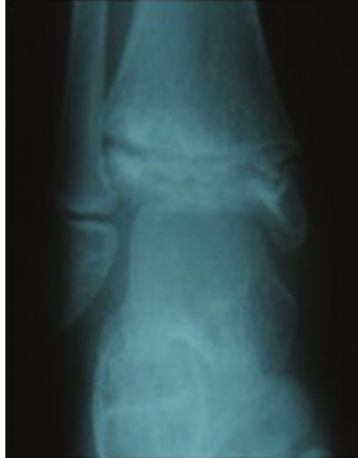
Figure 2: AP view of the ankle showing flattening and sclerotic appearance of distal tibial epiphysis. Irregular narrowing of the distal physis is seen with sclerosis rounding a lucency of the metaphyseal side of the growth plate. Note the normal appearance of the distal fibula growth